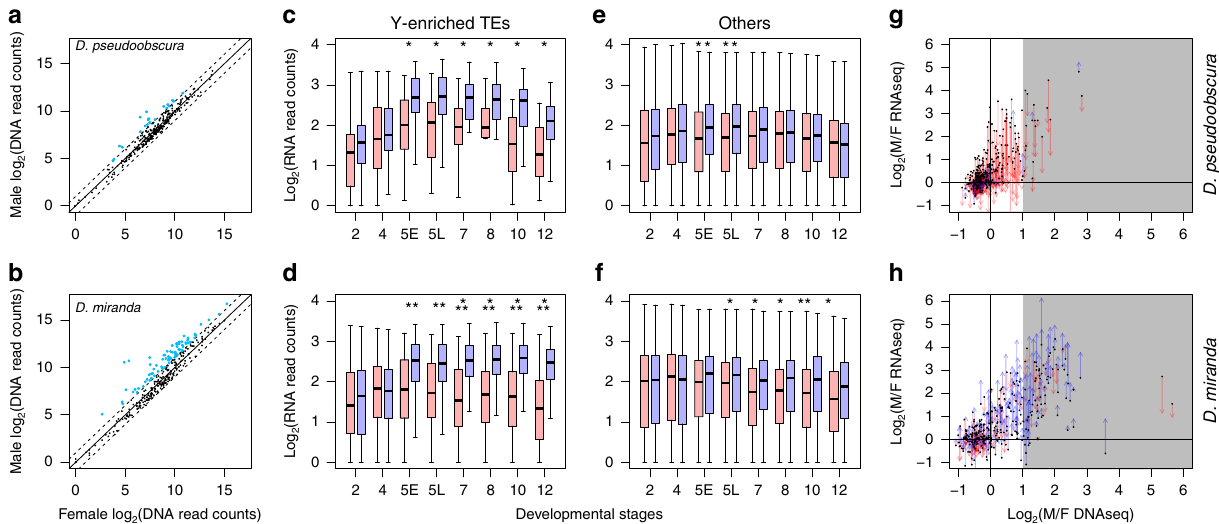
Fig. 3 Y-linked TEs drive male-biased expression in both D. pseudoobscura and D. miranda . a , b Regression between female and male DNA-seq read counts mapping to TEs. TEs with more than twice the abundance in males are deemed Y-enriched (blue). Solid diagonal delineate the identity line, dotted lines delineate ±2-fold differences. c , f Boxplots depict the transcript abundances of either the Y-enriched ( c , d ) or remaining ( e , f ) TEs between the sexes (female in red and male in blue) and across developmental stages. *, **, and *** denote signi fi cant differences between males and females with p value of <0.05, <0.0005, and <0.000005, respectively (two-tailed Wilcoxon rank-sum test, no multiple testing correction; n = 20, 79, 283, and 224 consensus TEs for c , d , e , and f , respectively). In the boxplots, whiskers delineate the minima and maxima of the distributions, the boxes demarcate the 25th and 75th percentiles, and the centers mark the medians. g , h Fold difference between female and male DNA-seq read counts plotted against that from RNA-seq read counts at stage 5. Gray background demarcate cutoff for Y-enriched TEs. Fold expression differences between sexes for each TE are shown at developmental stages 5 (dots) and 12 (arrowheads). The color of the vertical line denotes whether the expression of a TE becomes less (red) or more (blue) male biased across the development. Source data are provided as a Source data fi